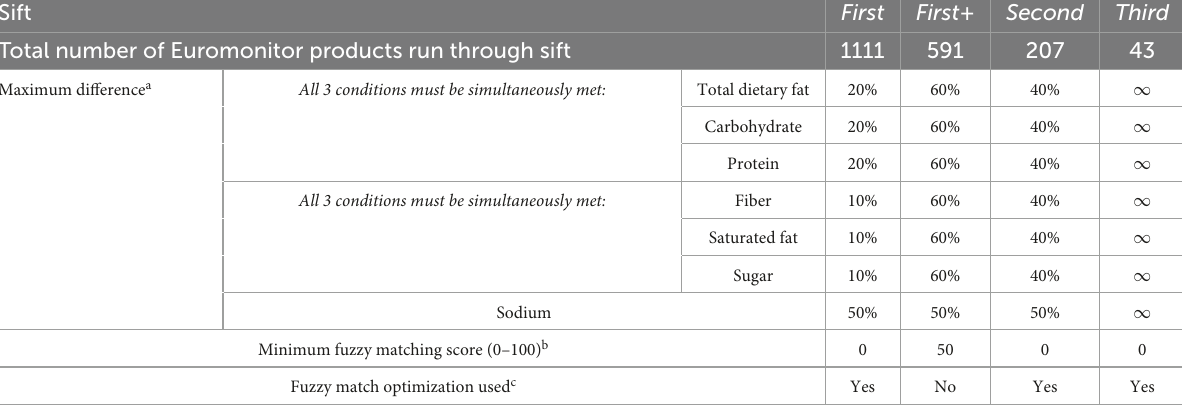
TABLE 1 Sets of thresholds as differences between Euromonitor and Canadian Nutrient File (CNF), as applied in each sift of our algorithm. Sift First First + Second Third Total number of Euromonitor products run through sift 1111 Maximum difference a All 3 conditions must be simultaneously met: Total dietary fat